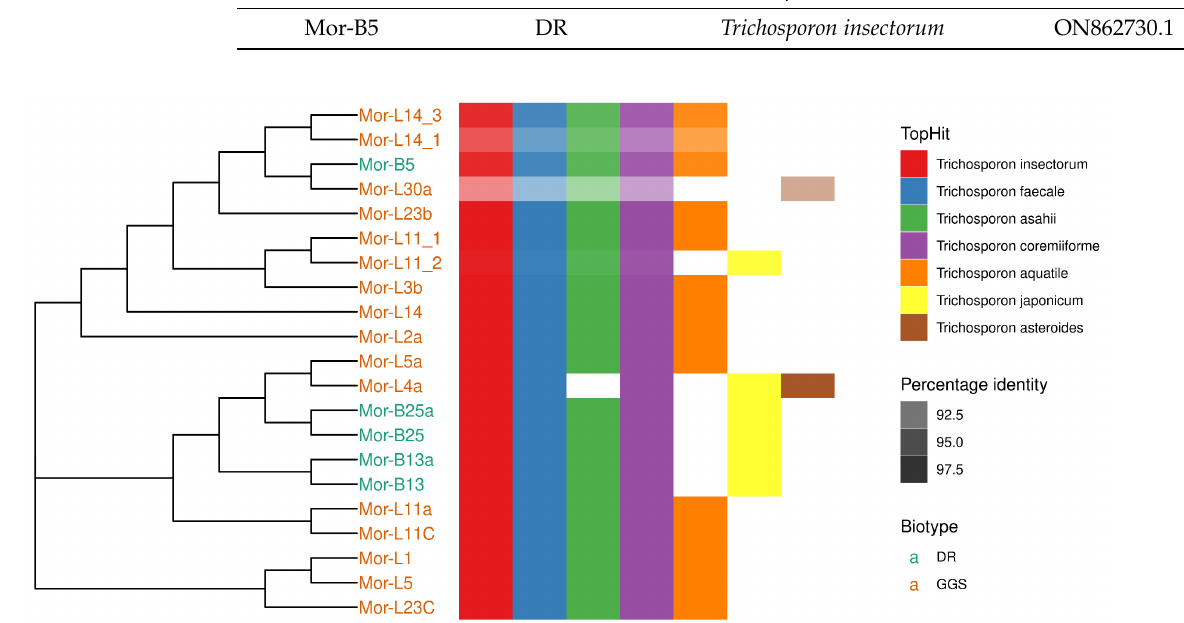
Figure 8. Phylogenetic tree and top 5 BLAST hits of all the strains. Darkness of the color increases as the percentage identity increases.